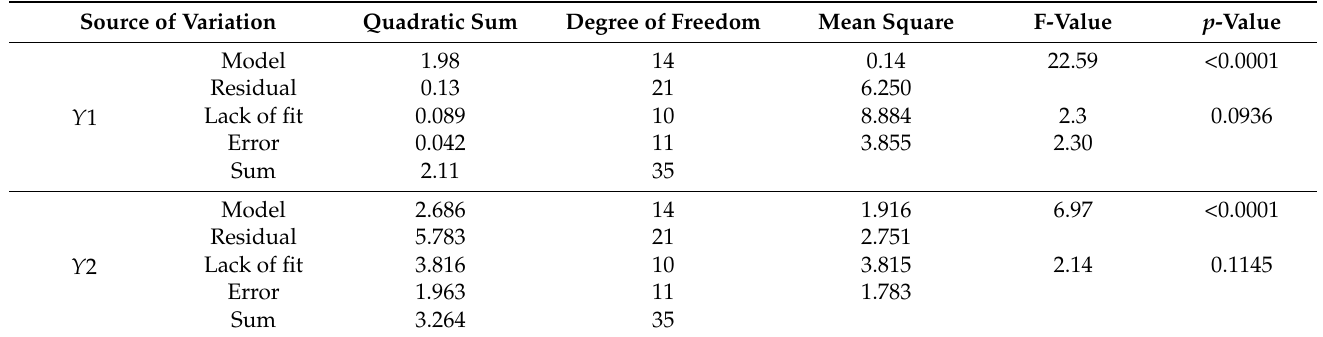
Table 5. Variance analysis of regression